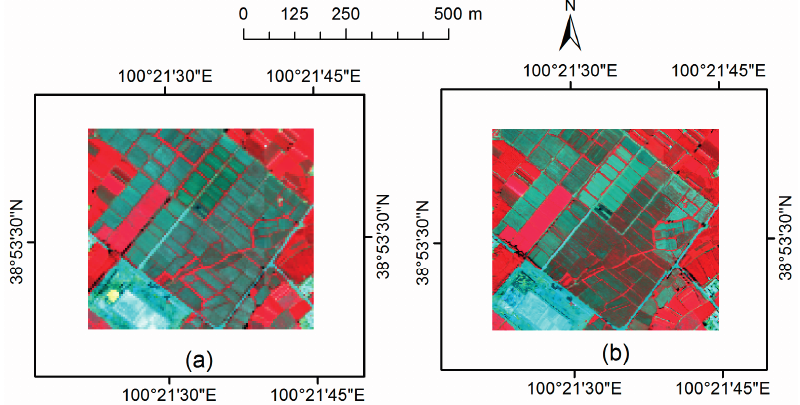
Figure 12. Changes in land cover with time. ( a ) CASI image acquired on 29 June (DOY 181); ( b ) CASI image acquired on 8 July (DOY